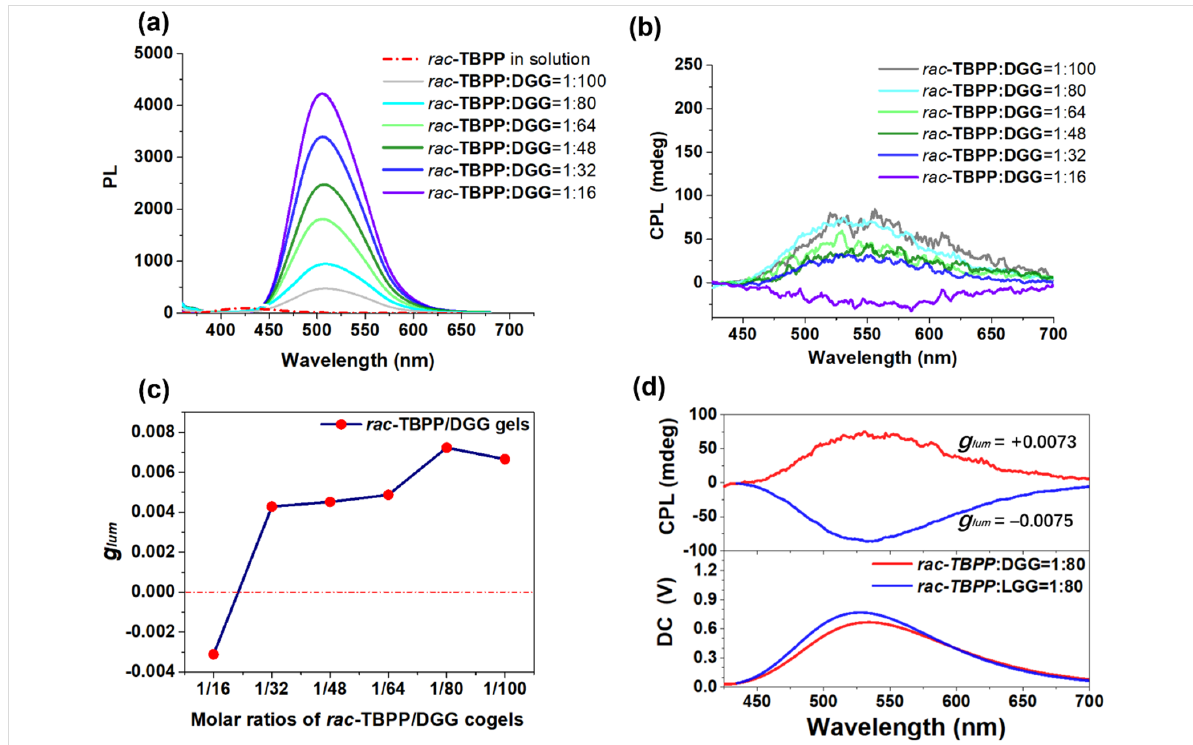
Figure 2: (a) Fluorescence spectra of rac - TBPP in solution (dash line) and in the rac - TBPP / DGG co-gels. (b) CPL spectra of the rac - TBPP / DGG co-gel at molar ratios from 1:100 to 1:16. (c) Plot of g lum value of CPL signals versus ratios of rac - TBPP / DGG in the co-gel. (d) Mirror symmetry in CPL spectra of rac - TBPP / DGG co-gel (red line) and rac - TBPP / LGG (blue line) co-gel at the molar ratio of